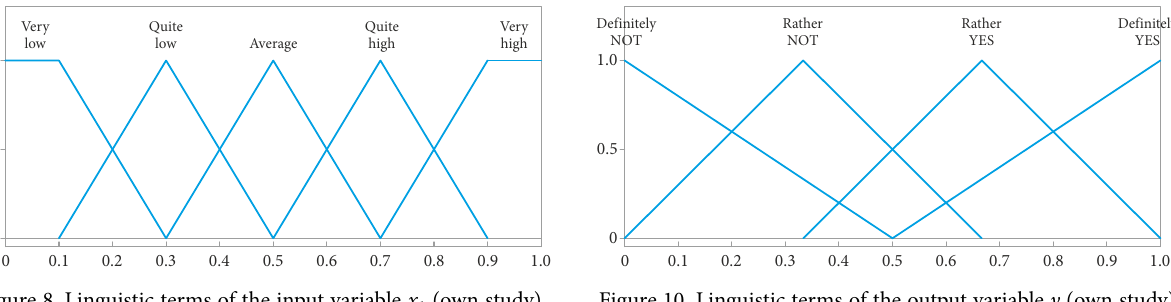
Figure 8. Linguistic terms of the input variable x 1 (own study) Figure 10. Linguistic terms of the output variable y (own study) Table 7. The results of expert studies of the risk impact assessment on the size of the life cycle costs of buildings, taking into account the possibility of the occurrence of a given risk factor at various stages of their life cycle (own study) Risk